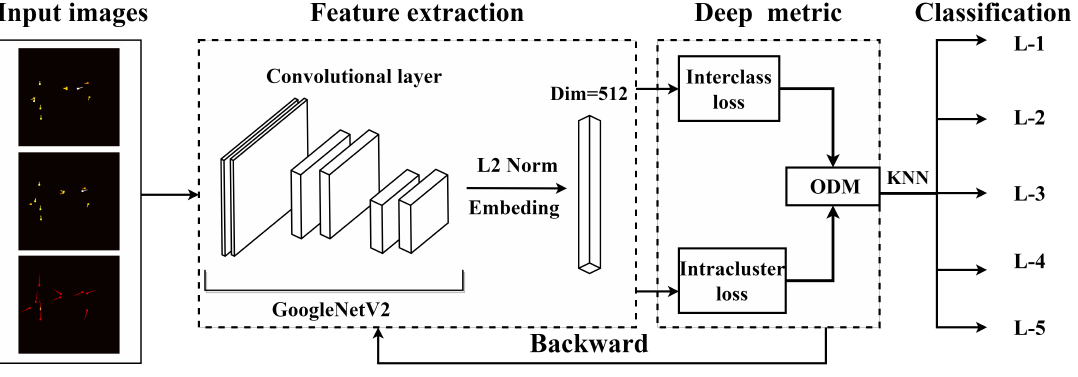
Figure 6. Framework of